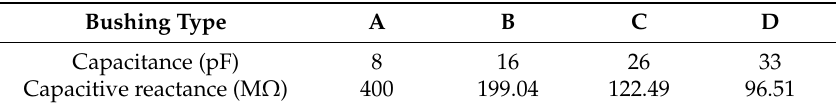
Table 7. Capacitance and capacitive reactance of bushing